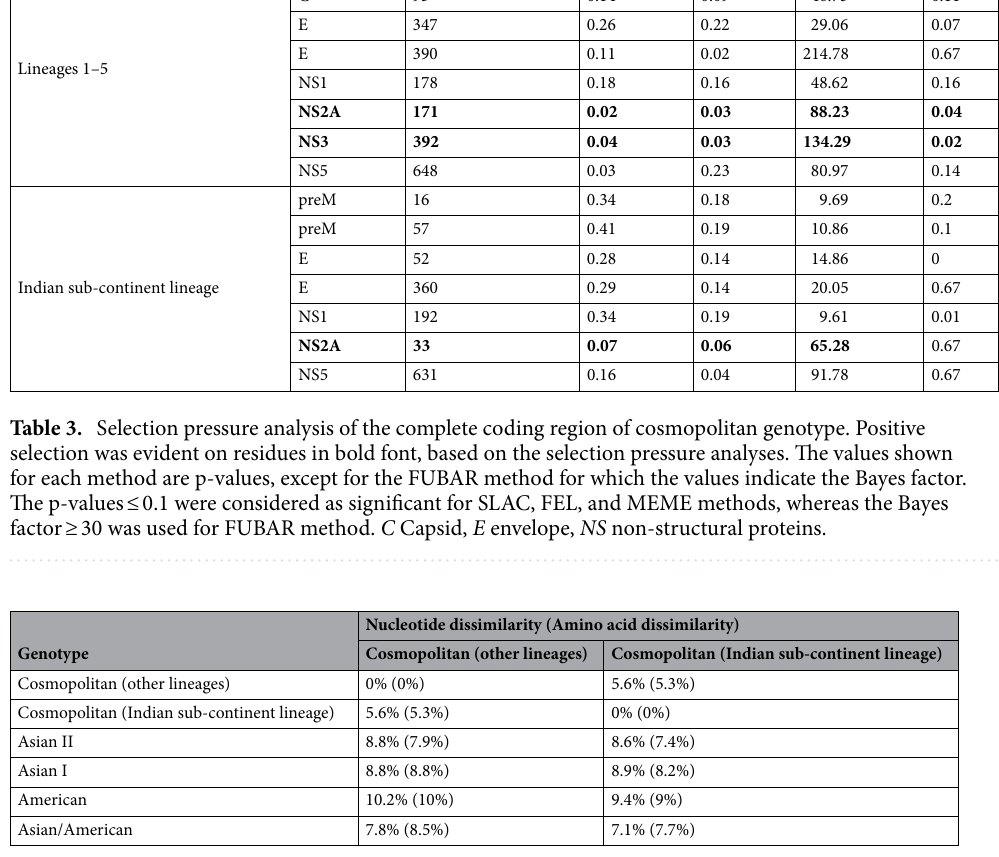
Table 4. Comparison of E gene divergence matrices between the Indian sub-continent lineage and other lineages of cosmopolitan genotype and other genotypes of DENV-2.